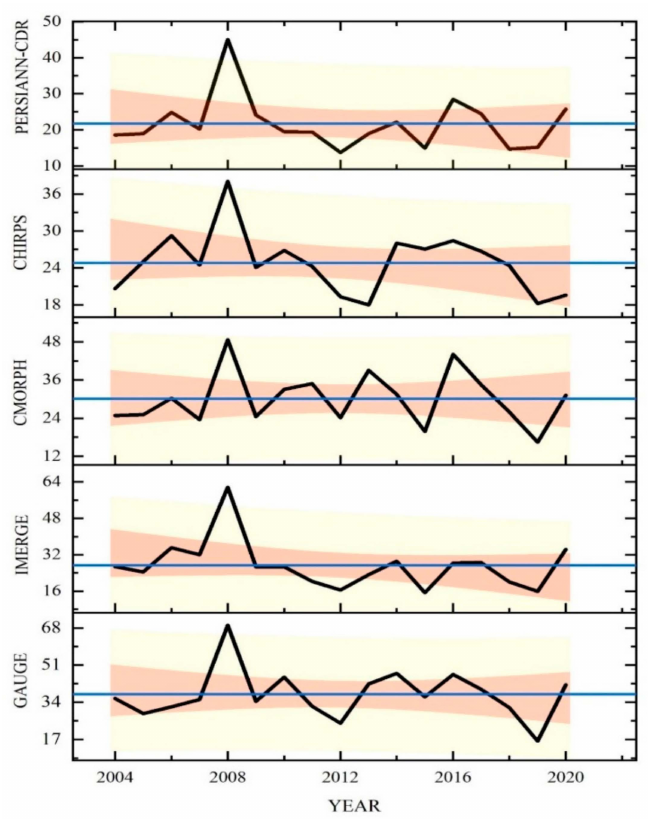
Figure 10. Precipitation Concentration Index ( PCI ) distribution over the study period for different satellite products and rain gauge observations over UAE. Thick continuous black line = PCI , straight blue line = mean value, light brown band = confidence band, yellowish wider band = prediction